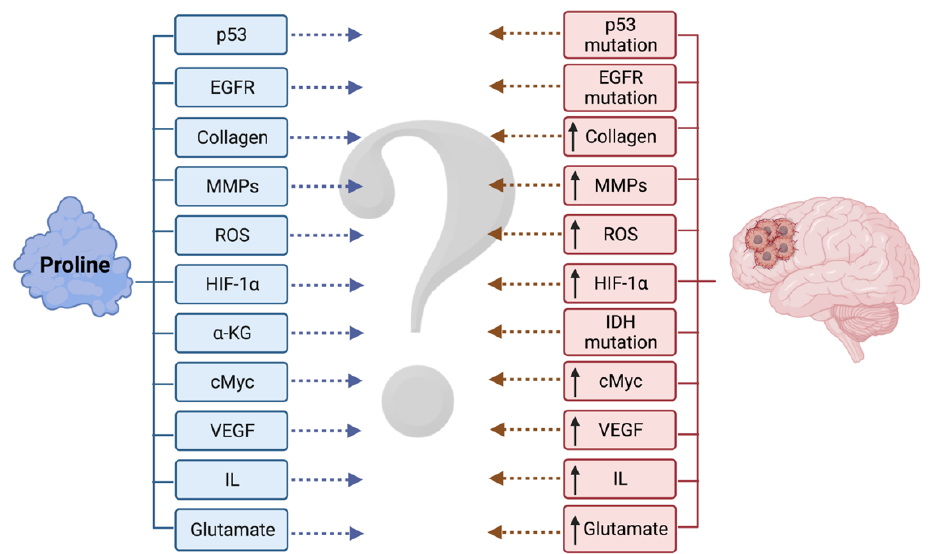
Figure 4. Malignant gliomas are still one of the most enigmatic clinical entities. Although our knowledge of proline metabolism in tumors is constantly expanding, synthesis of data pertaining to both of these domains is lacking. ↑ upregulated. Created with BioRender.com, accessed on 2 February